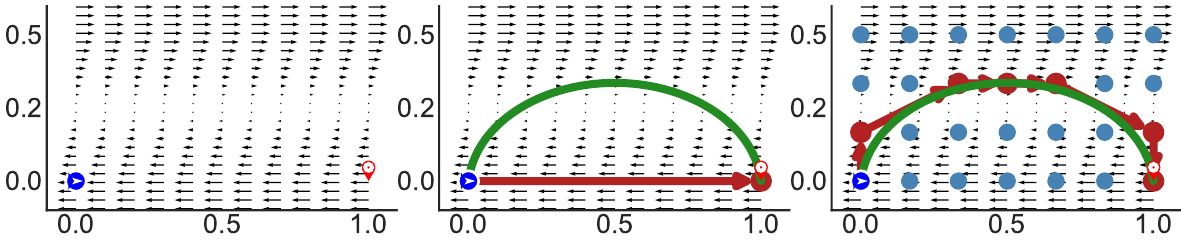
Figure 2. Test problem (a) with H = 0.5, x O = ( 0,0 ) , x D = ( 1,0 ) , ¯ w = 1 1/ h x = 1 and 6, respectively, red: discrete optimal trajectory, green: continuous optimal